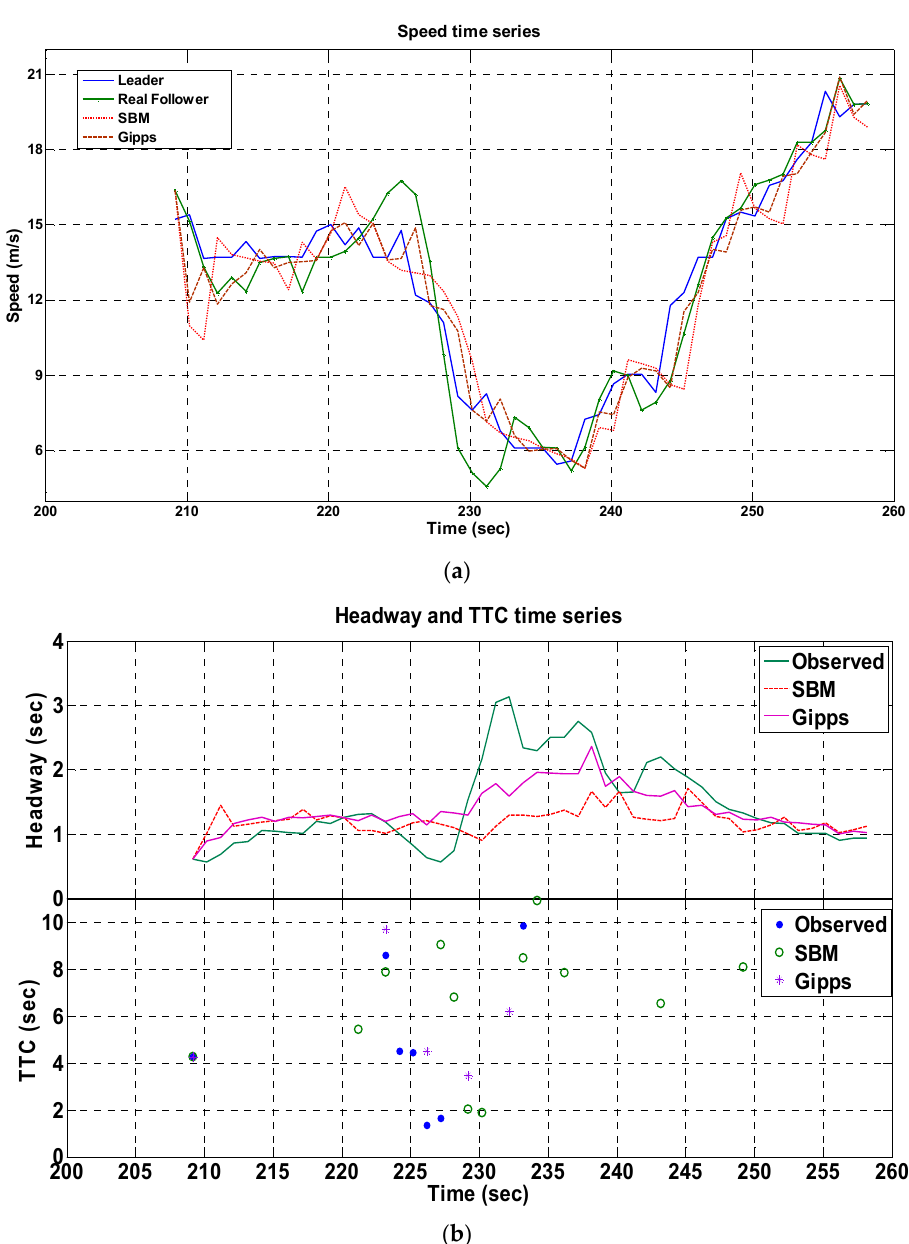
Figure 2. ( a ) Speed comparisons for a pair of leaders and following vehicles. ( b ) Headway profile and short time-to-collision events for a pair of leaders and following